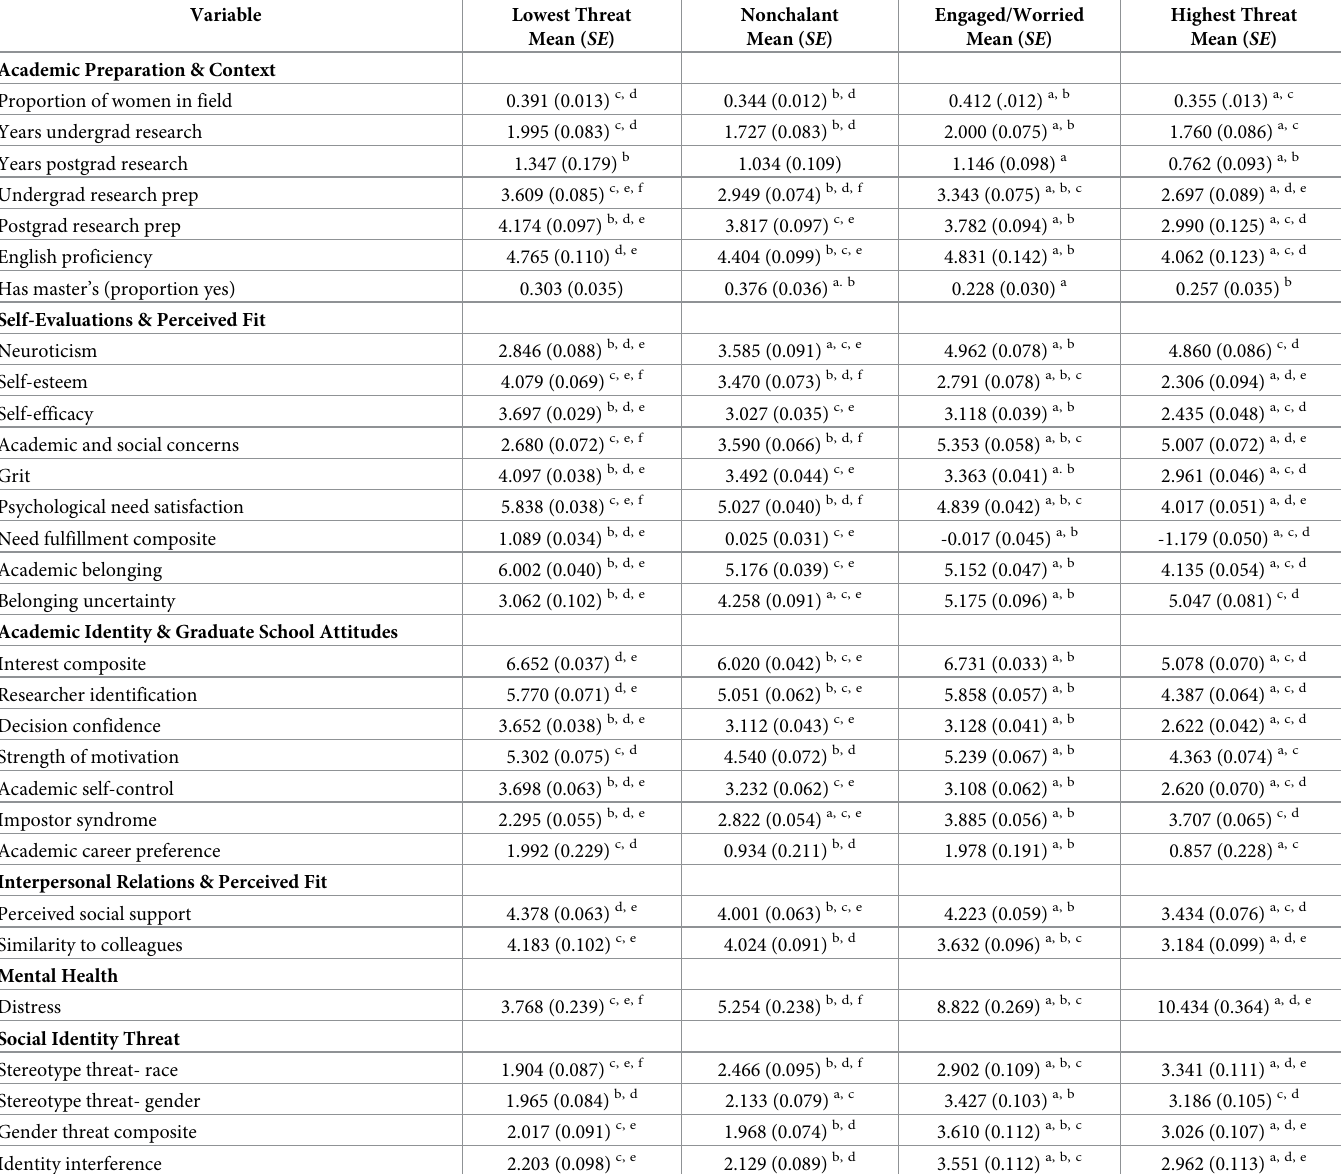
Table 7. How class membership is associated with descriptive